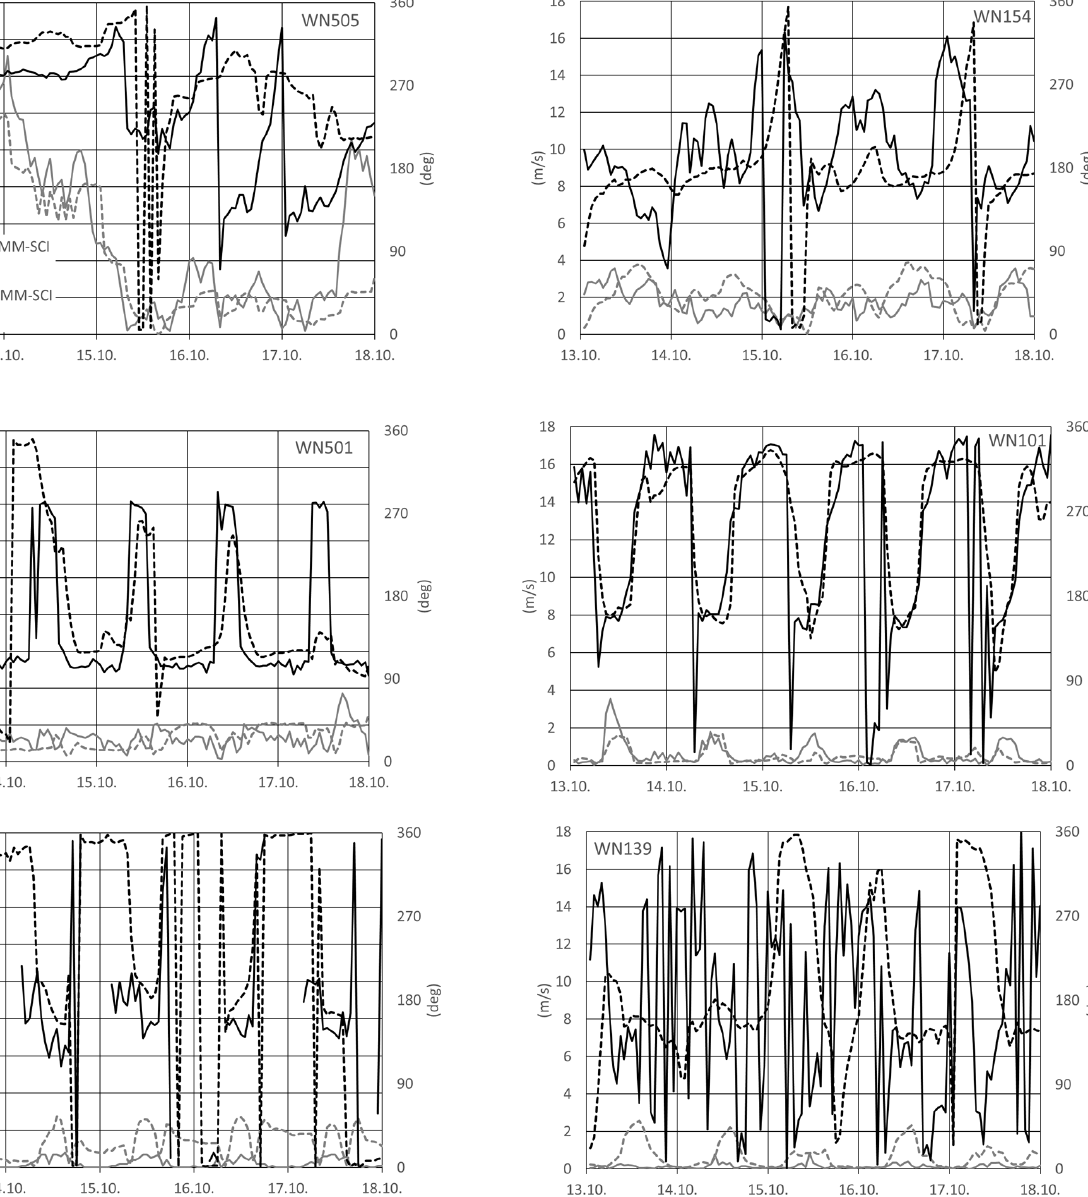
Figure 9. Observed and modelled wind speed and direction at selected sites in the Johnsbach ( left ) and Feldbach ( right ) domains. Dotted lines refer to GRAMM-SCI results, full lines to observations, black refers to wind direction, and grey to wind speed.